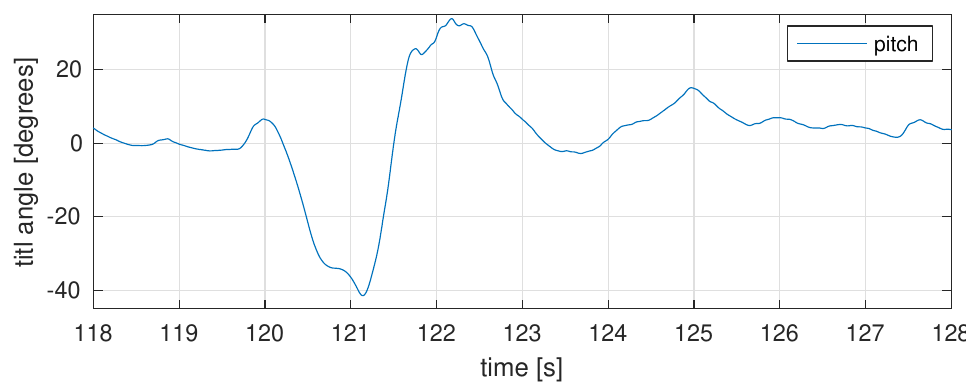
Figure 25. Flight experiments.